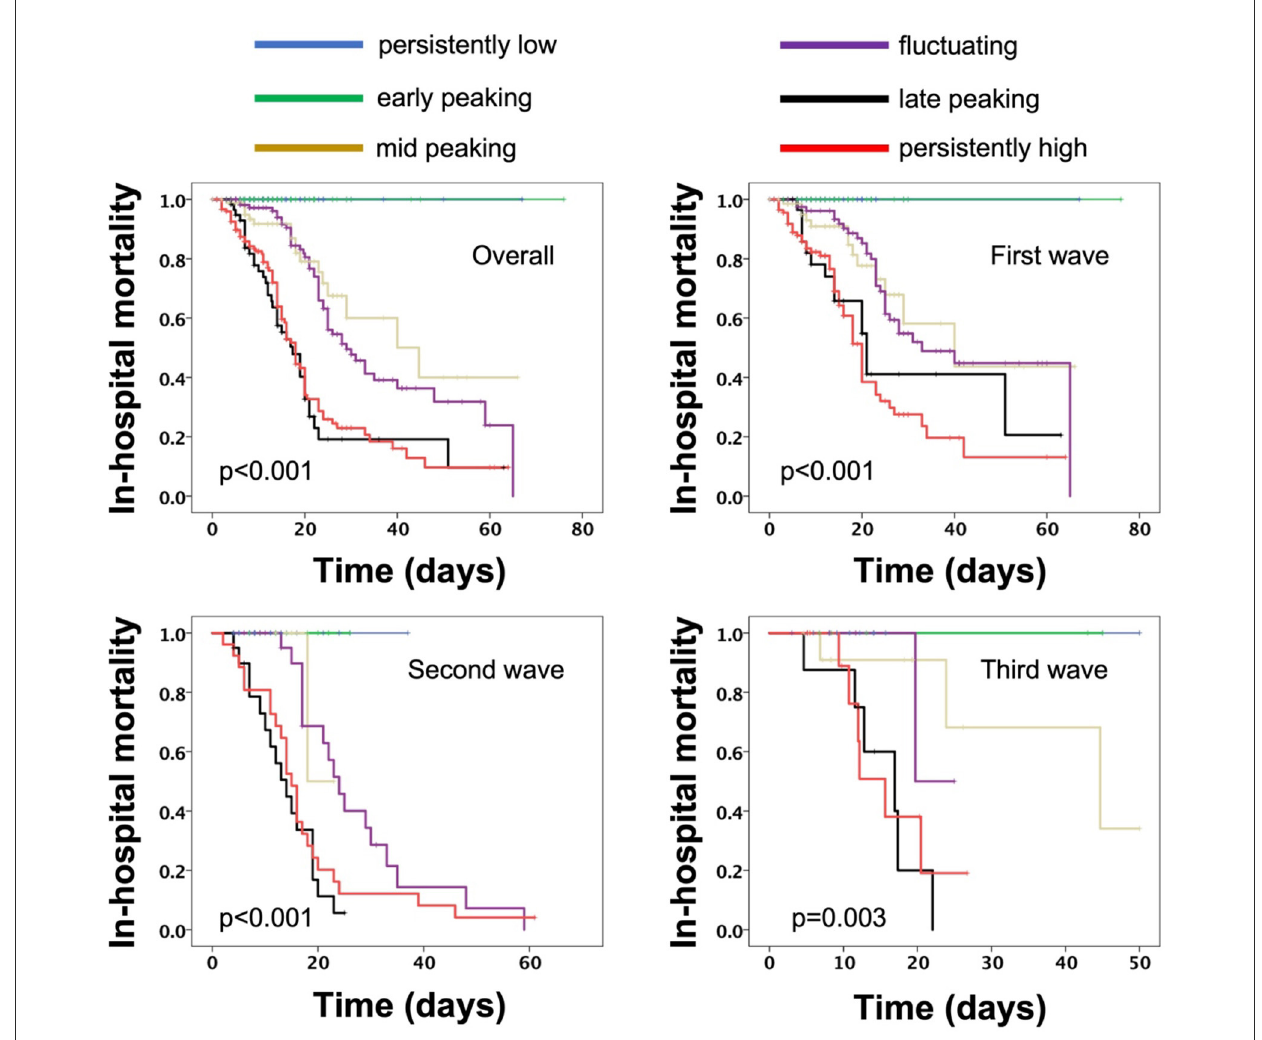
FIGURE3 Kaplan–Meier curves for in-hospital mortality overall as well as during the first, second, and third